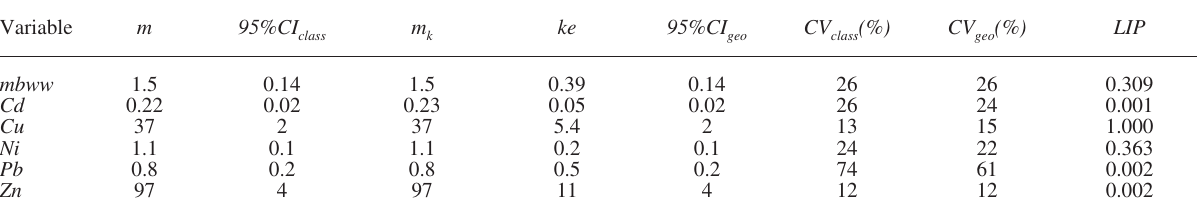
Table 3. – Comparison of classical and geostatistical population estimates of the variables mean body wet weight ( mbww ) of shrimps per sample (g), Cd , Cu , ni , Pb and Zn (mg kg -1 dW) in Crangon crangon from the north sea (Box a).